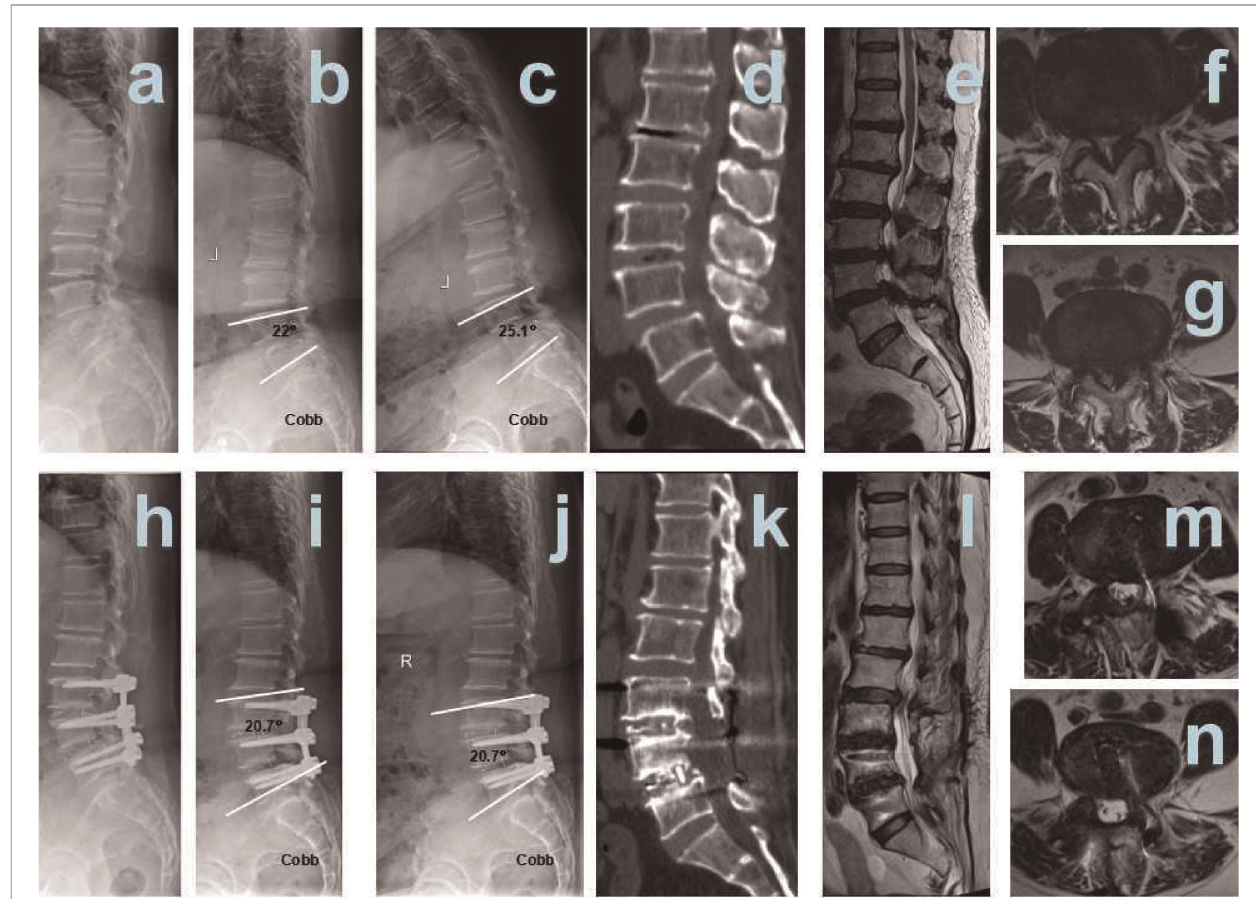
FIGURE 6 | TLIF patient 2. ( A ) Pre-surgical lateral X-ray; ( B ) pre-surgical hyper-extension X-ray; ( C ) pre-surgical hyper- fl exion X-ray; ( D ) pre-surgical CT showed L3/4, L4/5 spinal stenosis, L4 I° spondylolisthesis; ( E ) pre-surgical T2-weighted MRI sagittal plane showed L3/4, L4/5 spinal stenosis; ( F ) pre-surgical MRI showed L3/4 spinal stenosis; ( G ) pre-surgical MRI showed L4/5 spinal stenosis; ( H ) 12 months after surgery, post-surgical lateral X-ray; ( I ) 12 months after surgery, post-surgical hyper-extension X-ray; ( J ) 12 months after surgery, post-surgical hyper- fl exion X-ray; ( K ) 12 months after surgery, post-surgical CT showed interbody fusion; ( L ) 12 months after surgery, post-surgical T2 weighted MRI sagittal plane; ( M ) 12 months after surgery, post-surgical MRI sagittal plane showed that L4/5 spinal stenosis was improved signi fi cantly; and ( N ) 12 months after surgery, post-surgical MRI sagittal plane showed that L5/S1 spinal stenosis was improved signi fi